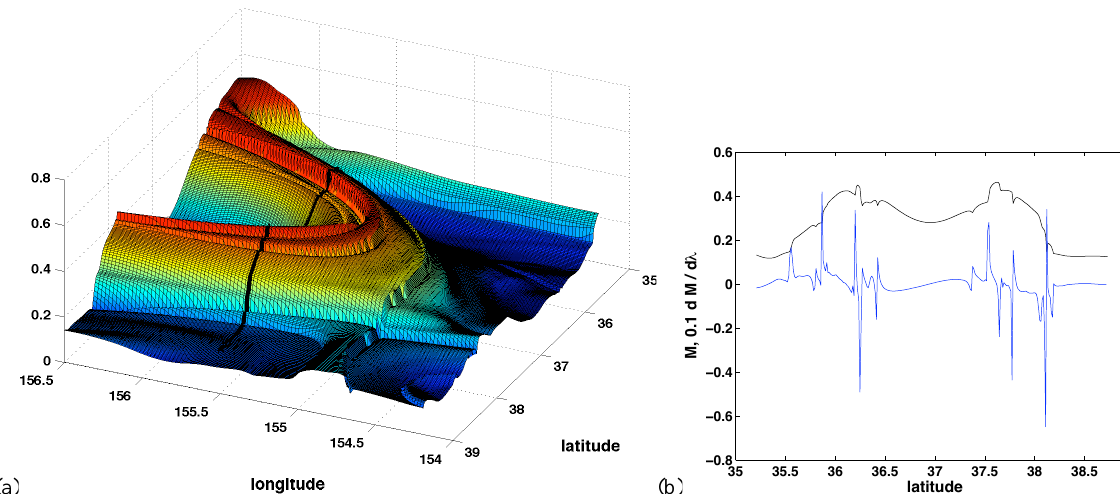
Fig. 2. (a) A representation of the function M over a small oceanic area on 2 May 2003 for τ = 15 days; (b) In black the function M vs. latitude at a fixed longitude highlighted in (a) with the thick black line. Abrupt changes in M pointing manifolds positions corresponds with discontinuities on the derivative. In blue 0.1 times the derivative of M with respect the latitude.